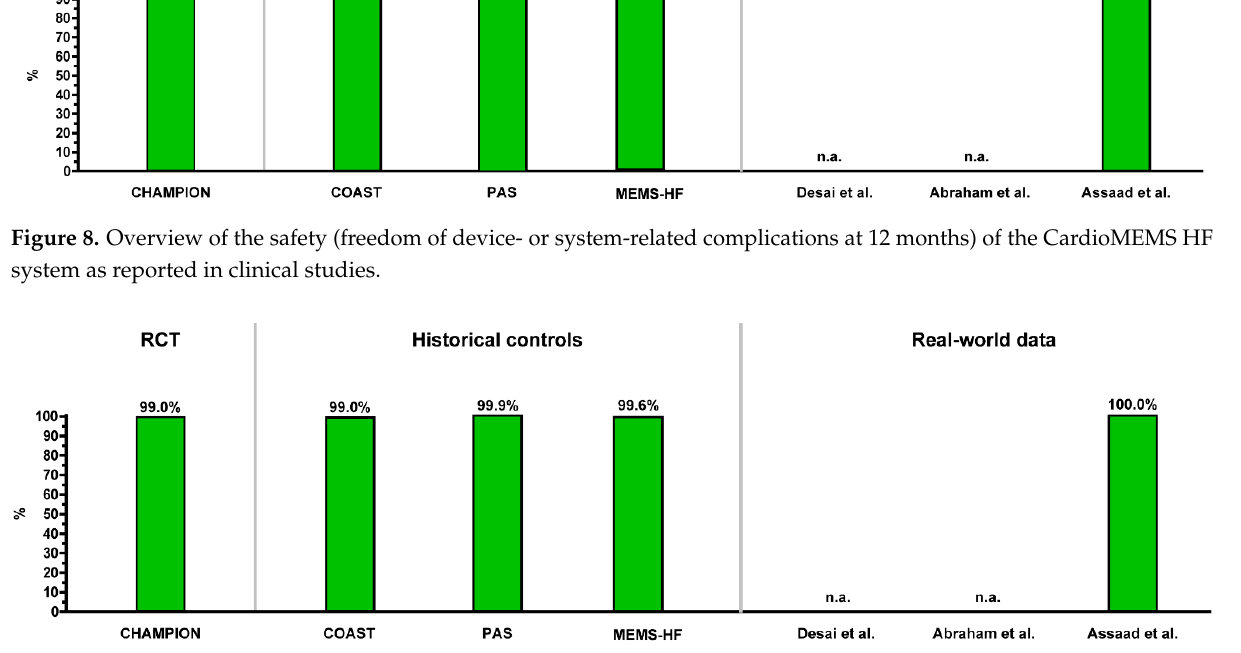
Figure 9. Overview of the reliability (freedom of sensor failures at 12 months) of the CardioMEMS HF system as reported in clinical studies.